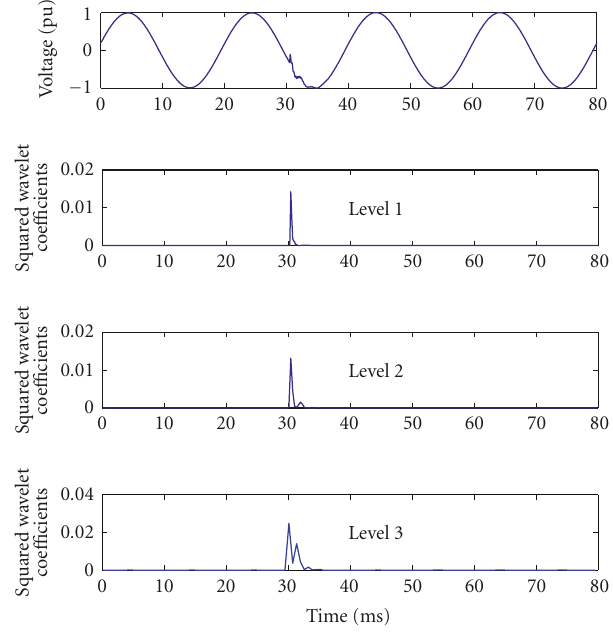
Figure 4: Capacitor-switching transient waveform and squared wavelet coe ffi